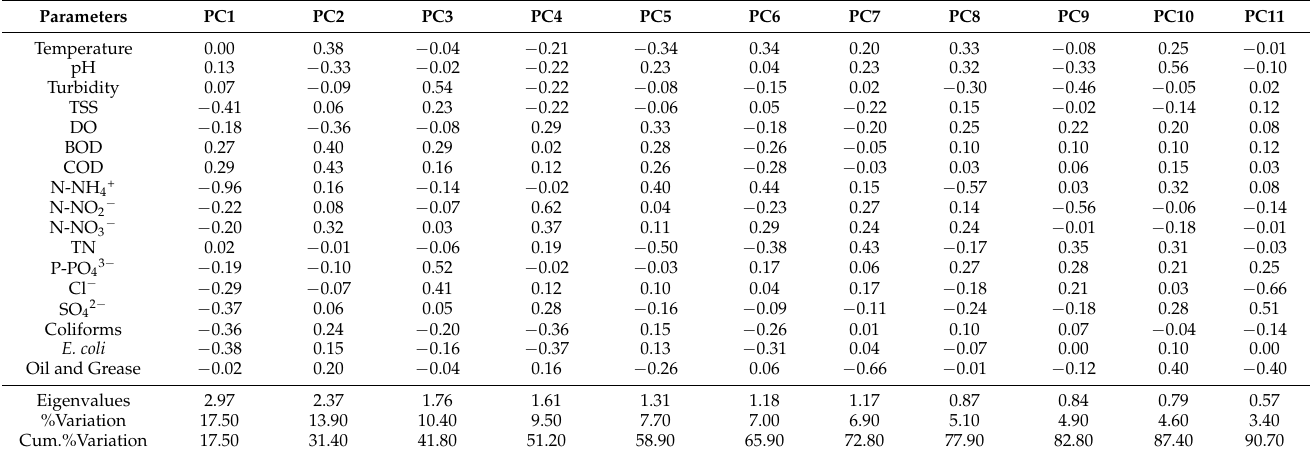
Table 2. PCA for water quality data in the water quality in Dong Thap province in